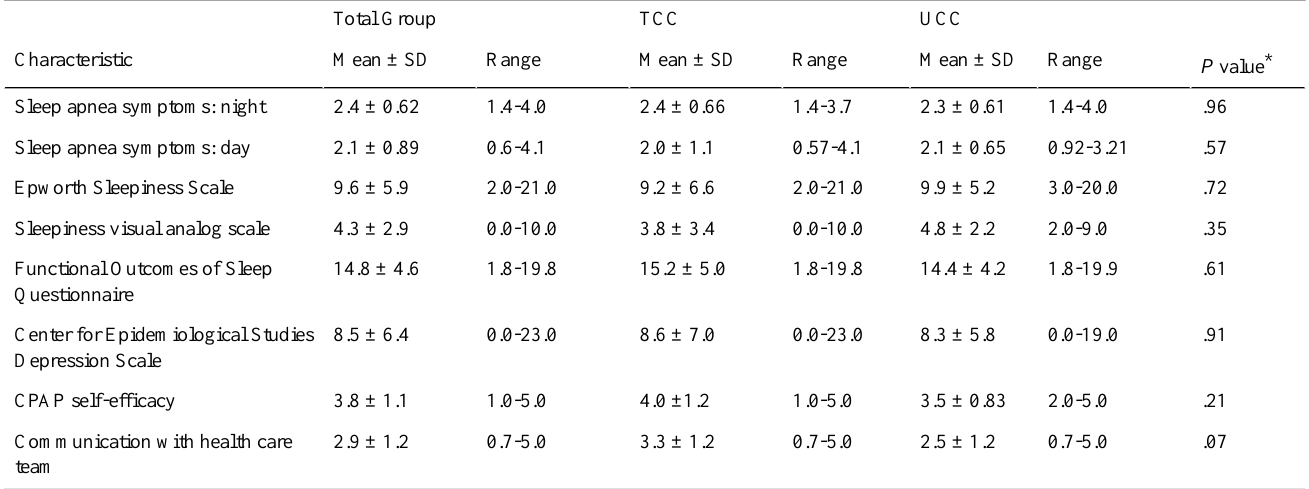
Table 6. Outcome measures, postintervention